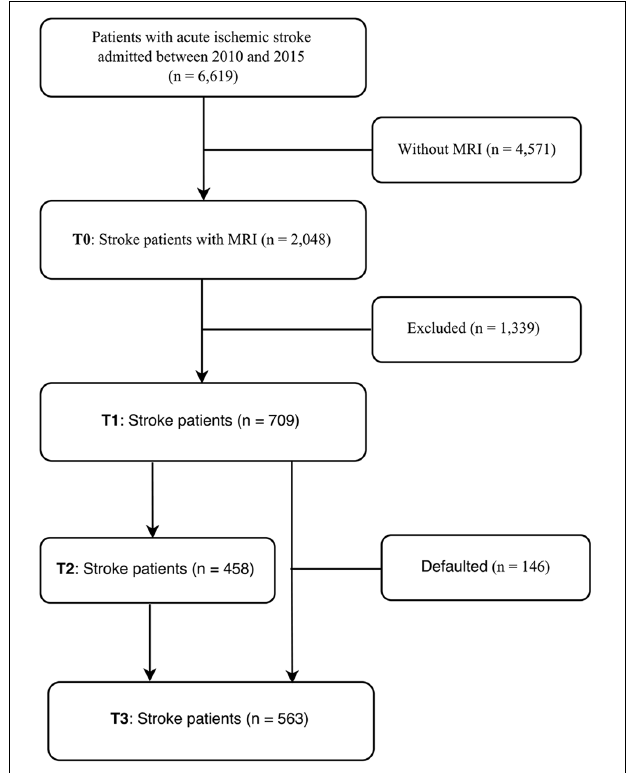
FIGURE 1 | Flow chart of the